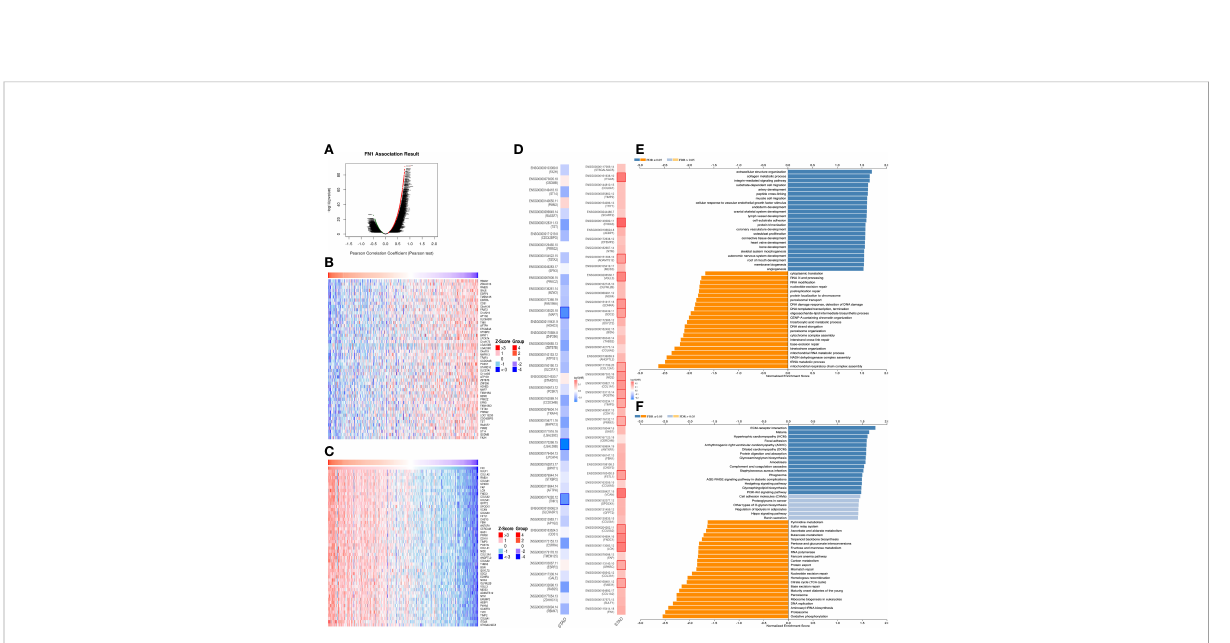
FIGURE 3 The coexpression genes with FN1 in STAD from the LinkedOmics database. (A) The whole signi fi cantly associated genes with FN1 distinguished by Pearson test in the STAD cohort. (B, C) Top 50 genes positively and negatively related to FN1 in STAD showed, respectively, by heat maps. Red represents positively linked genes, and blue represents negatively linked genes. (D) Survival map of the top 50 genes positively and negatively associated with FN1 in STAD. (E, F) KEGG pathways and GO annotations of FN1 in the STAD